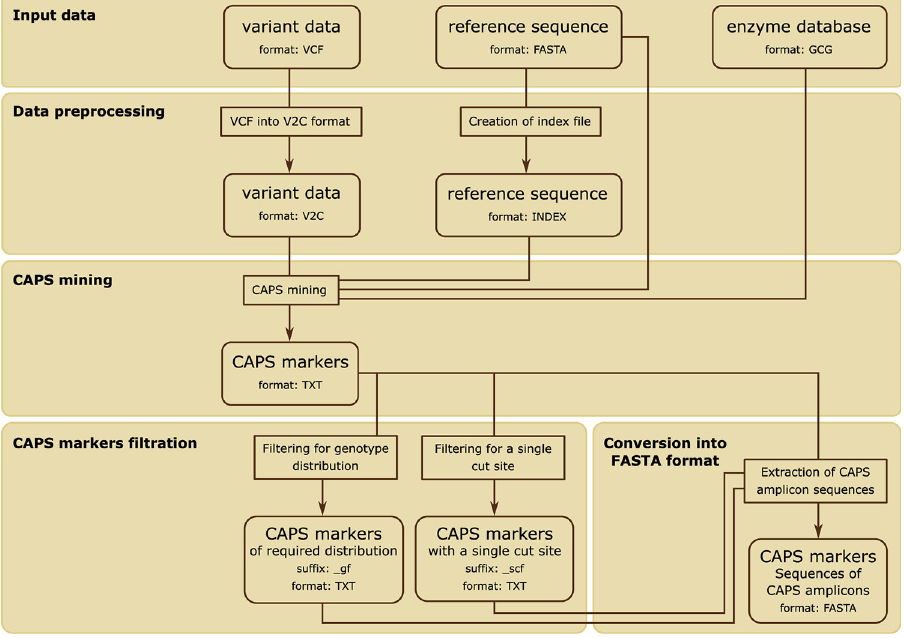
Fig 1. Visualization of the VCF2CAPS workflow.